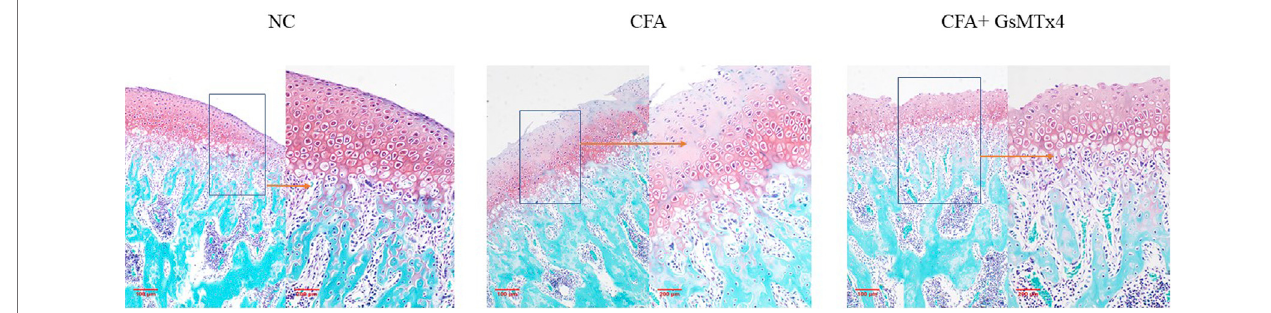
FIGURE 3 | NC: clear cartilage level; CFA: damage to the cartilage surface zone and value-added zone, partial damage of the hypertrophy zone; CFA + GsMTx4: damage to the surface zone and value-added zone, with a relatively complete hypertrophy zone.